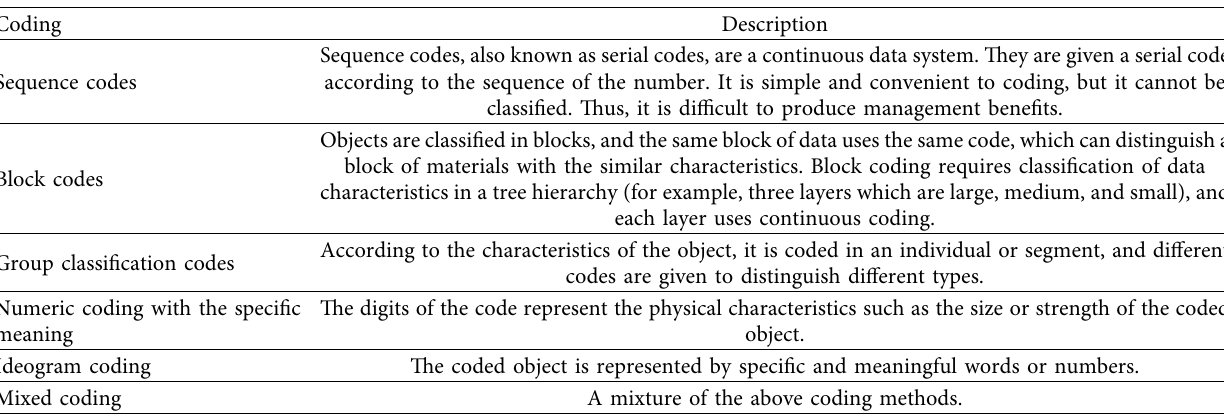
Figure 2: The proposed facility repair platform Table 1: Common coding method.